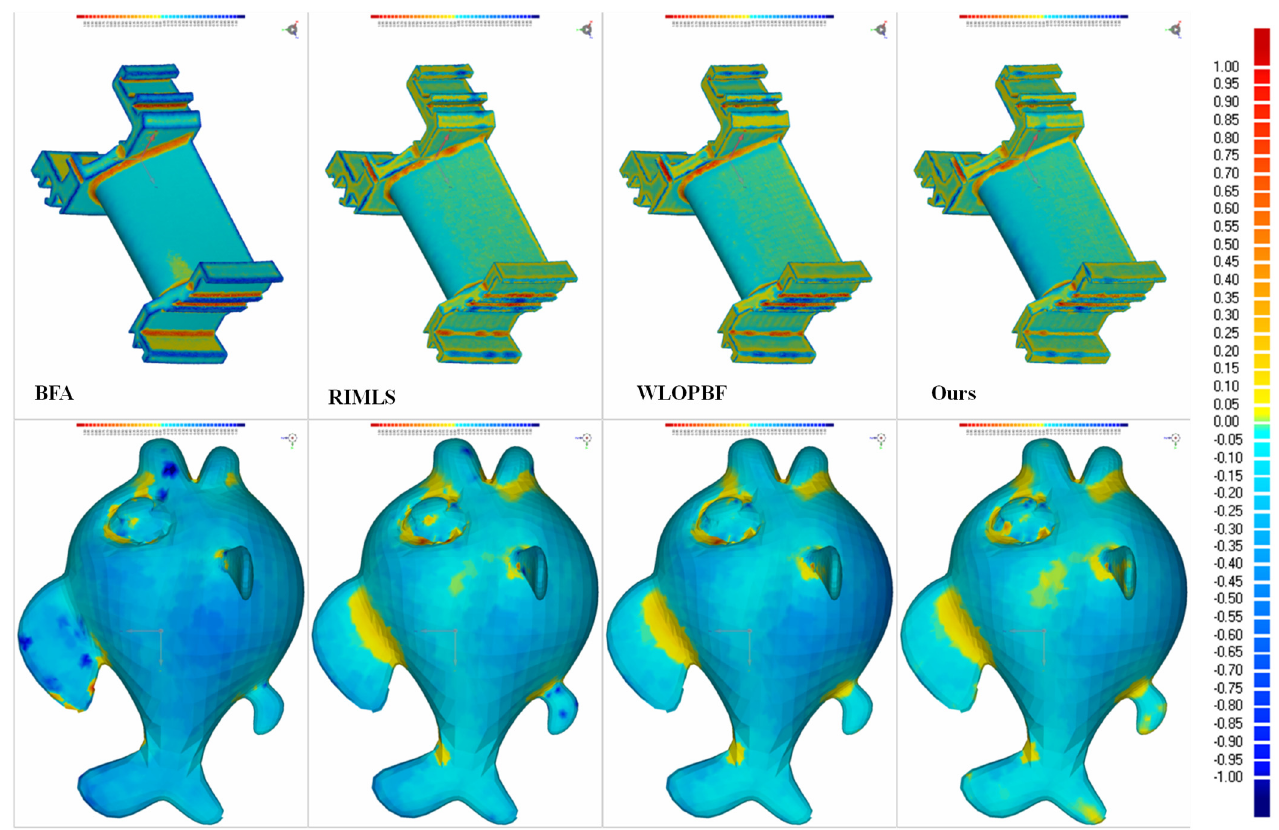
Figure 9. Small-scale noise filtering effects. ( Bottom ) are Fish point cloud; ( Top ) are Blade point cloud.